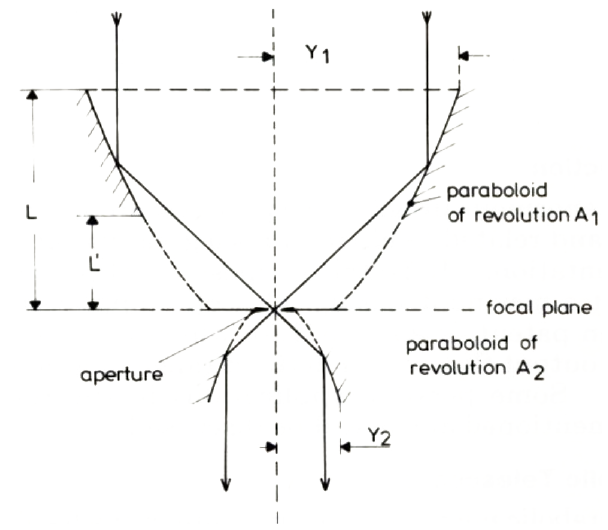
Figure 33. Telescope with two paraboloids of revolution to be used as a collimator (Reprinted from Schmidtke 1977; OSA copyright